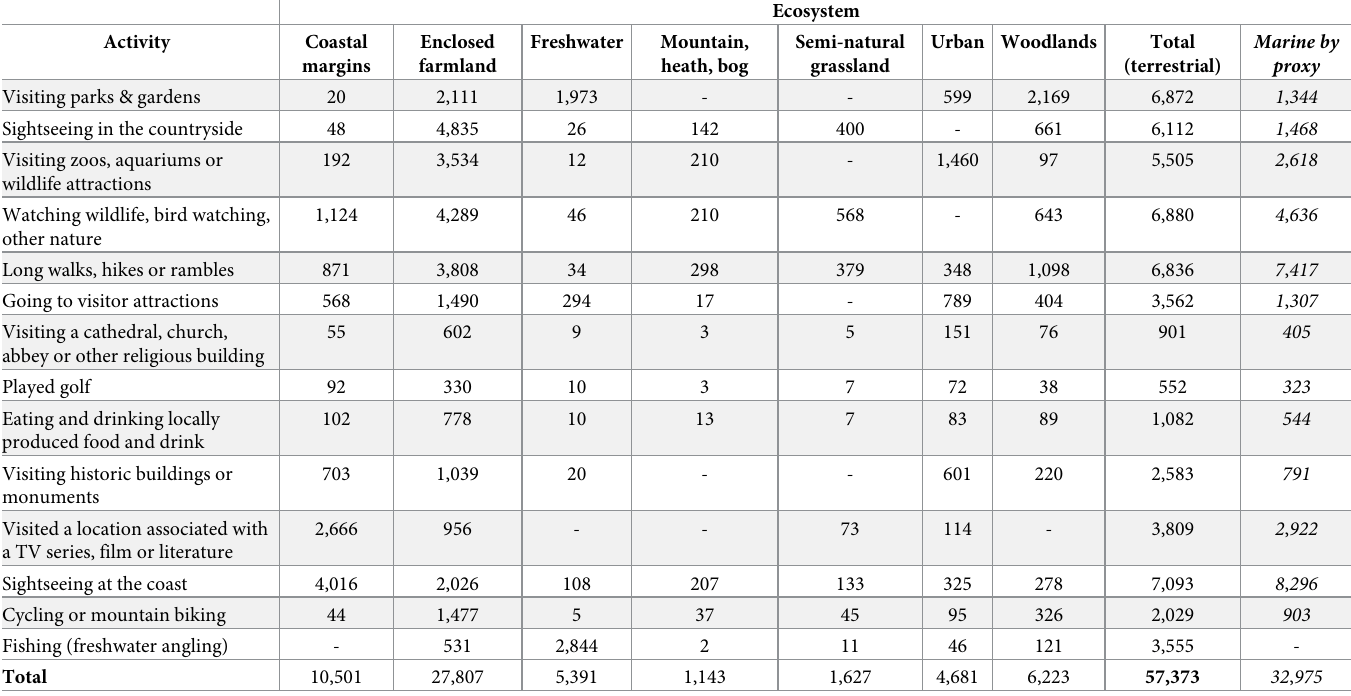
Table 5. Ecosystem breakdown of expenditure attributable to natural capital for 14 terrestrial activities in Pembrokeshire (£ thousands).